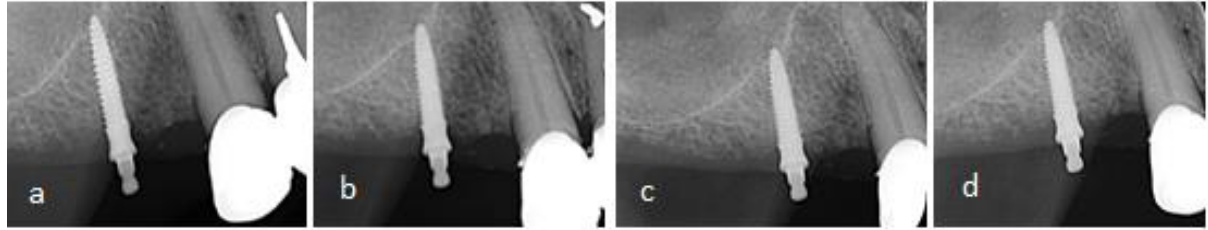
Figure 3. Marginal bone level (MBL) at mesial and distal sites of a MDI, ( a ) after insertion, ( b ) after one year, ( c ) after three years, ( d ) after five years of function.